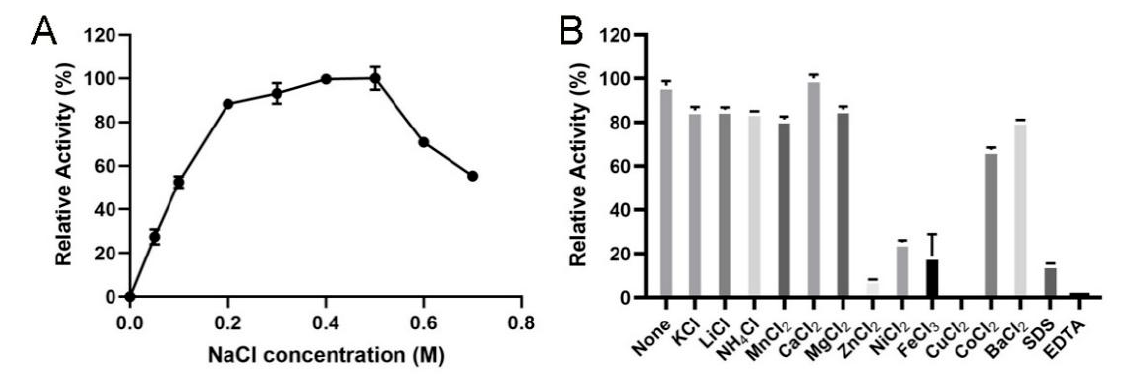
Figure 5. ( A ) The activities of VsAly7D with different the concentrations of NaCl. ( B ) The influences of metal ions, SDS or EDTA on VsAly7D.